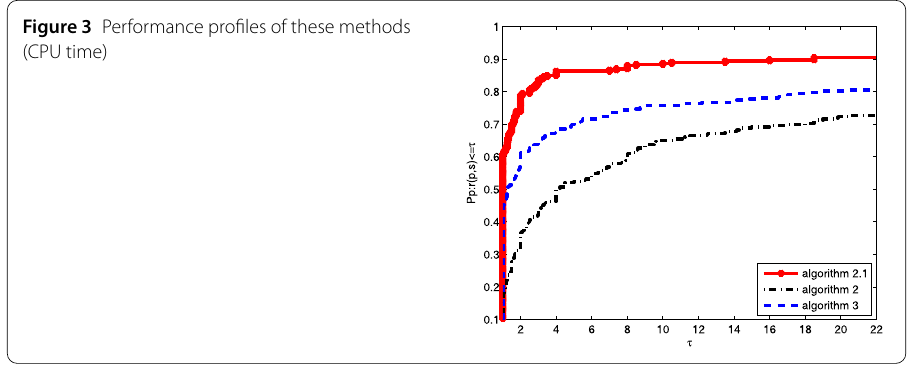
Figure 3 Performance profiles of these methods (CPU